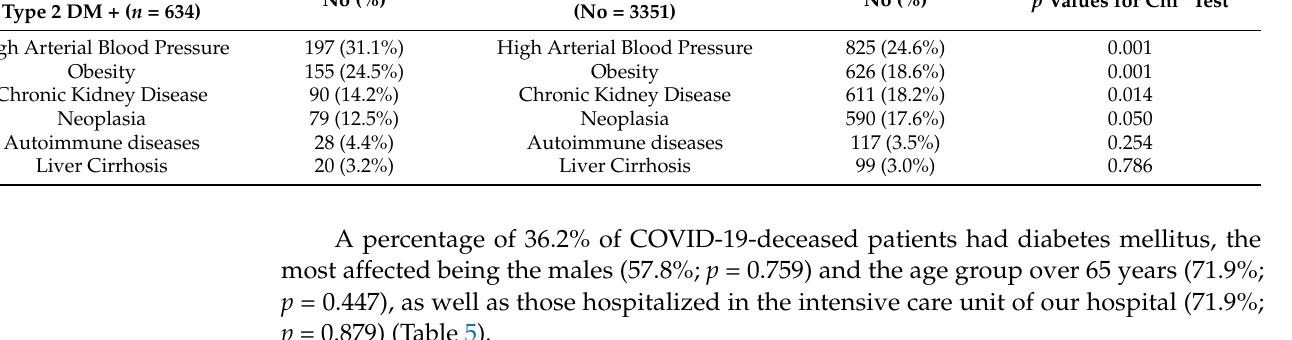
Table 4. Comorbidities of diabetic/nondiabetic patients with COVID-19. COVID-19 Patients with Type 2 DM + ( n = 634)